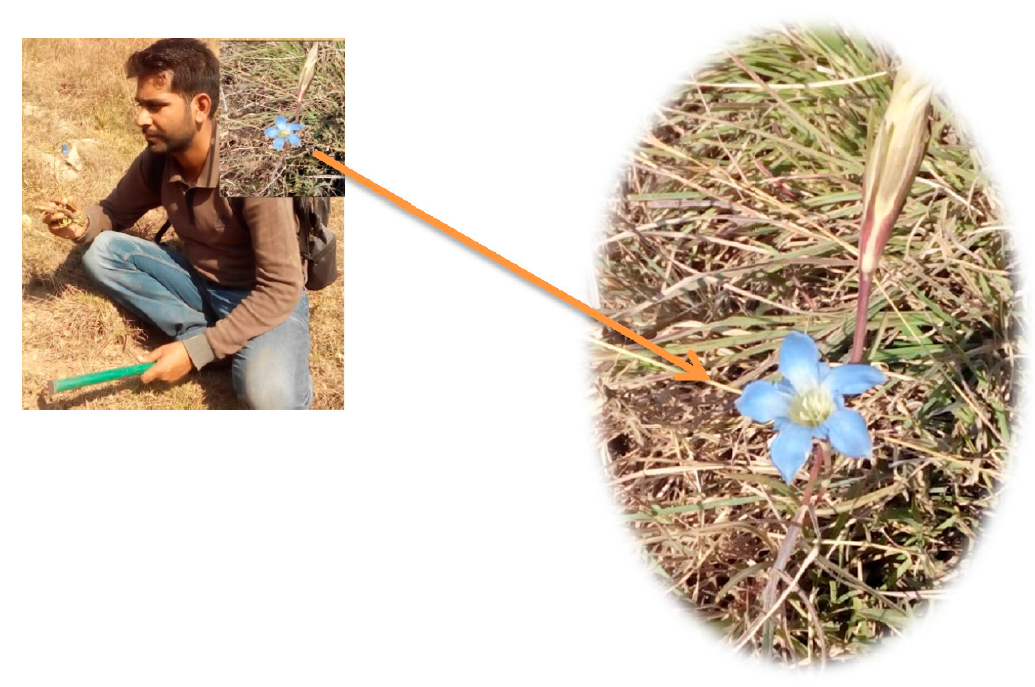
Figure 1. G. kurroo Royle collected from the Khrew village in the district of Pulwama, J&K.